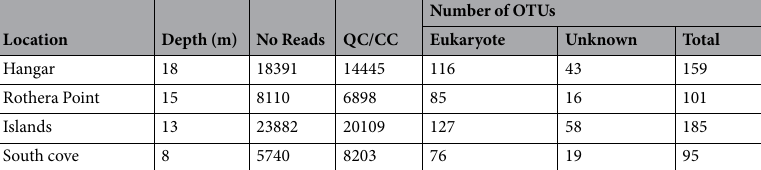
Table 1. Summary data for the sampled areas Hangar (HC), Rothera point (RP), Islands (I) and South Cove (SC) at Rothera in the Antarctic Peninsula. The number of reads before (No reads) and after denoising (QC/CC): QC: quality score; CC: chimera check) and total OTU numbers are shown. OTUs numbers were taxonomically assigned to the eukaryotes and unknown. The latter samples comprised both sequences with no matches in the SILVA reference database and also matches to unannotated environmental samples.